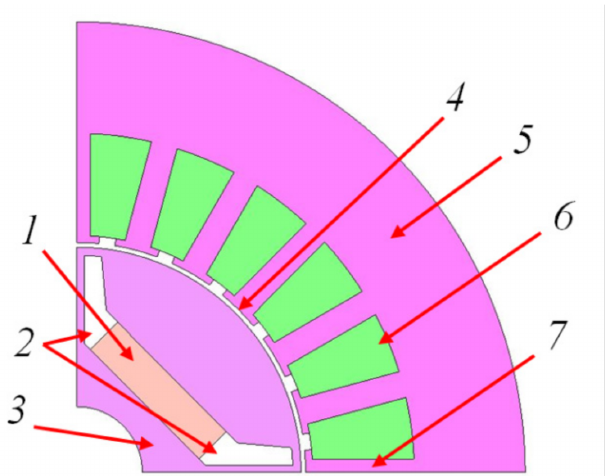
Figure 1. Initial interior permanent magnet synchronous motors (IPMSM) geometry in JMAG Designer that includes the permanent magnet (PM) (1), rotor slits (2), rotor core (3), air gap (4), stator back iron (5), stator slots (6), and stator teeth (7).